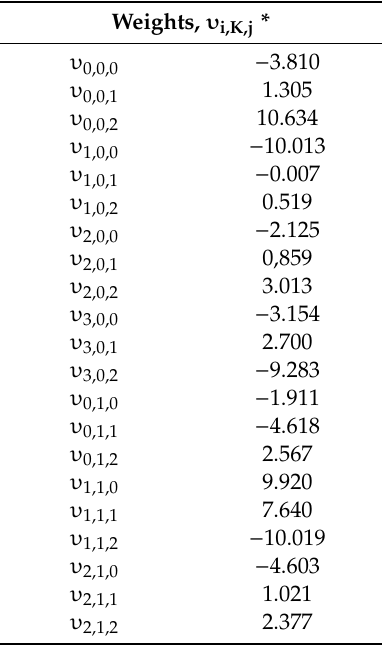
Table 4. The features of the AGENN model with [4-3-3-3-1] Artificial Neural